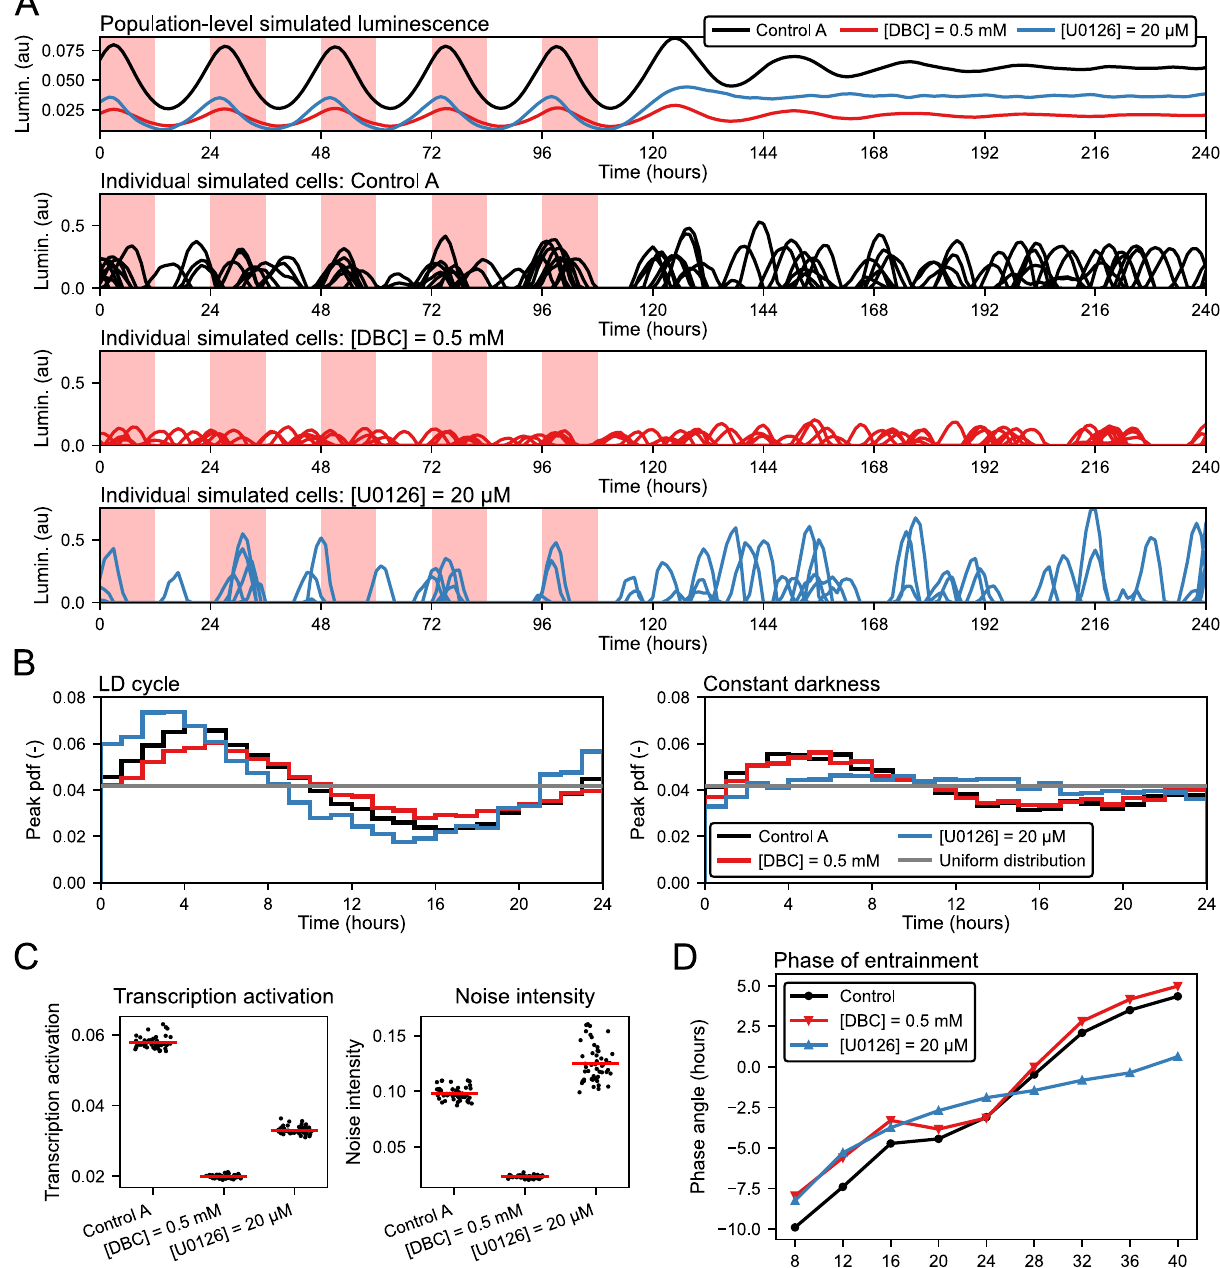
Figure 4. The population-level loss of amplitude is caused by different underlying single-cell mechanisms. ( A ) Output of the model under 5 days of LD cycle followed by 5 days of constant darkness. For each compound the population-level mean is displayed with 10 of the 30,000 individual traces from which the mean was calculated. ( B ) Histograms showing probability density function (pdf) of phases (peak positions of individual traces) under LD cycle and constant darkness (times between 72 and 96, and 122 and 146 hours of panel A ). ( C ) Transcription activation was calculated as mean of the output luminescence in constant darkness. The values for control ( L = 0.0576 ± 0.0017 ) are higher than the values for DBC ( L = 0.0198 ± 0.0004 ) and U0126 ( L = 0.0331 ± 0.0012 ). The noise intensity value for control ( σ = 0.098 ± 0.006 ) was lower than for U0126 ( σ = 0.124 ± 0.016 ) but higher than for DBC ( σ = 0.023 ± 0.001 ). Mean and standard deviation were calculated across the final population of parameter sets obtained by the evolutionary optimizer. ( D ) Simulated effect of the LD cycle period (T) on the phase of entrainment. The phase angle is calculated as the time interval between the light onset and the oscillation peak normalized by T/24. Negative values indicate that the oscillation peak is delayed with respect to the light